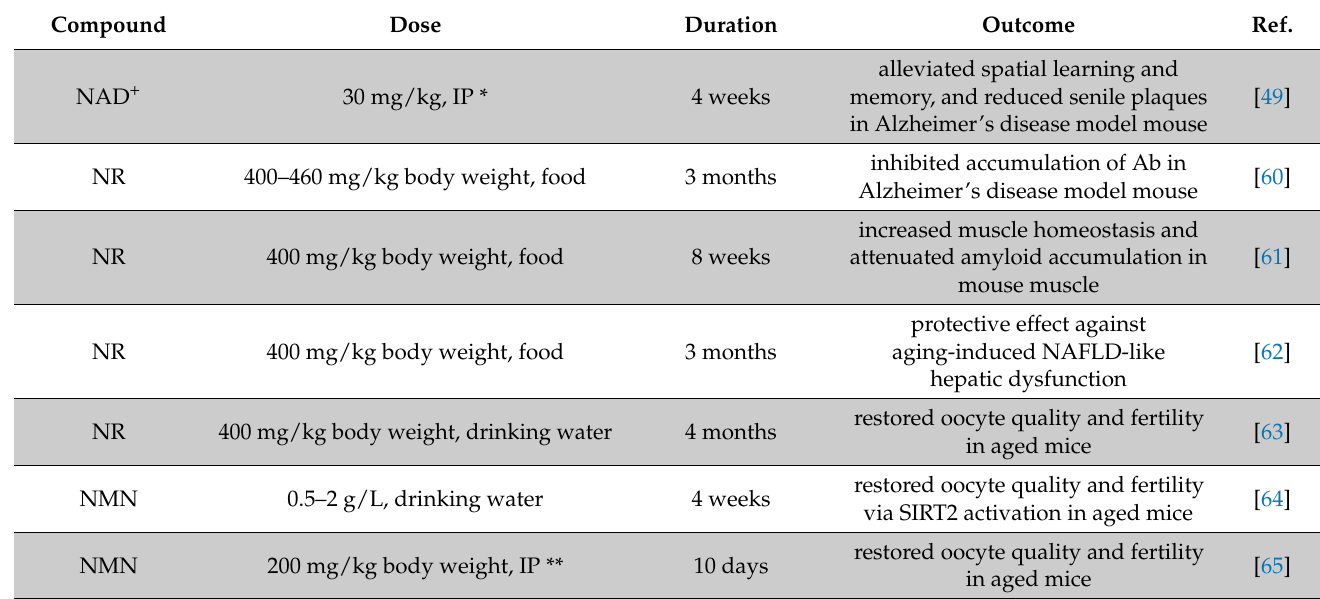
Table 1. Effects of administration of NAD + or precursors in